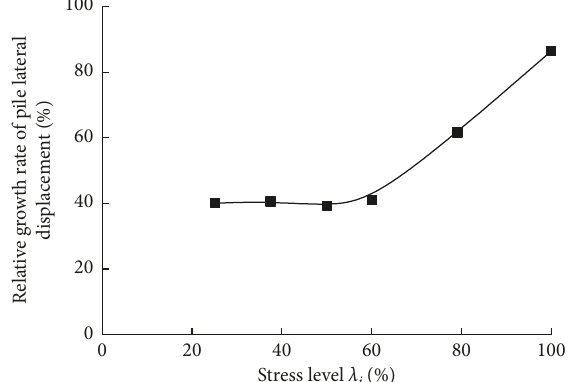
Figure 7: Relation curve between the relative growth rate of the pile lateral displacement and the stress level.